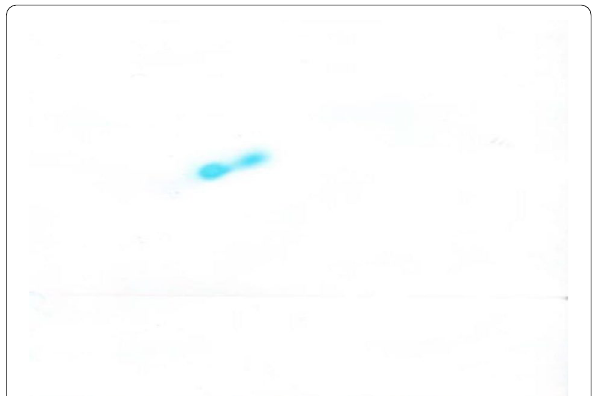
Fig. 1 2-DEP showing big dermatan sulfate spot diagnostic of a fetus affected with MPS VI